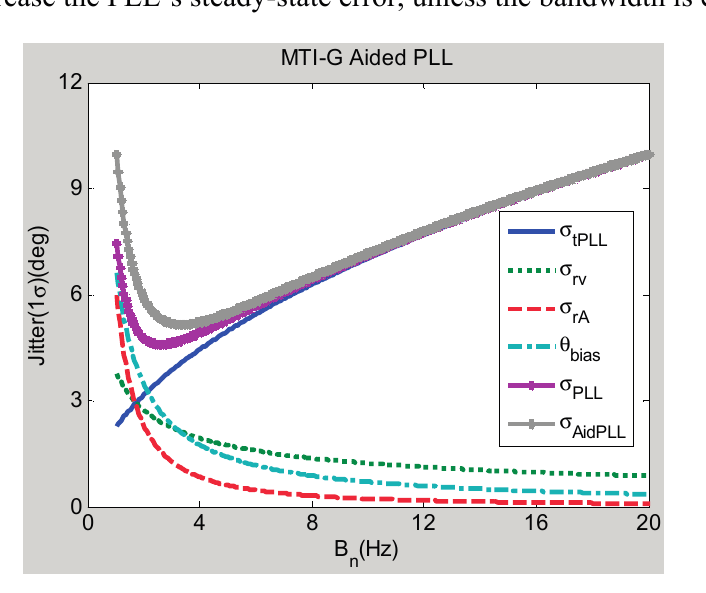
Figure 6. Tracking errors of MEMS INS-aided PLL under static conditions. MTI-G is a model of a typical low-grade INS.